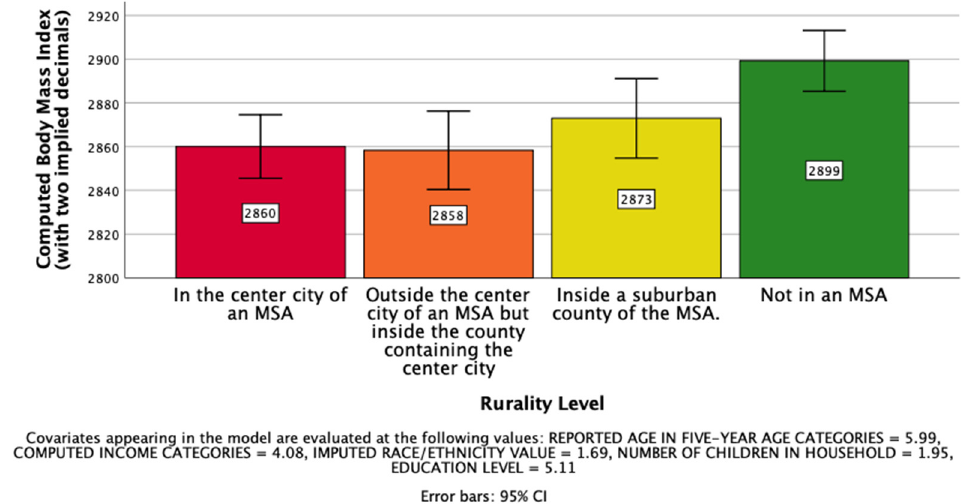
Figure 5. National Mean Daily Potato Intake.